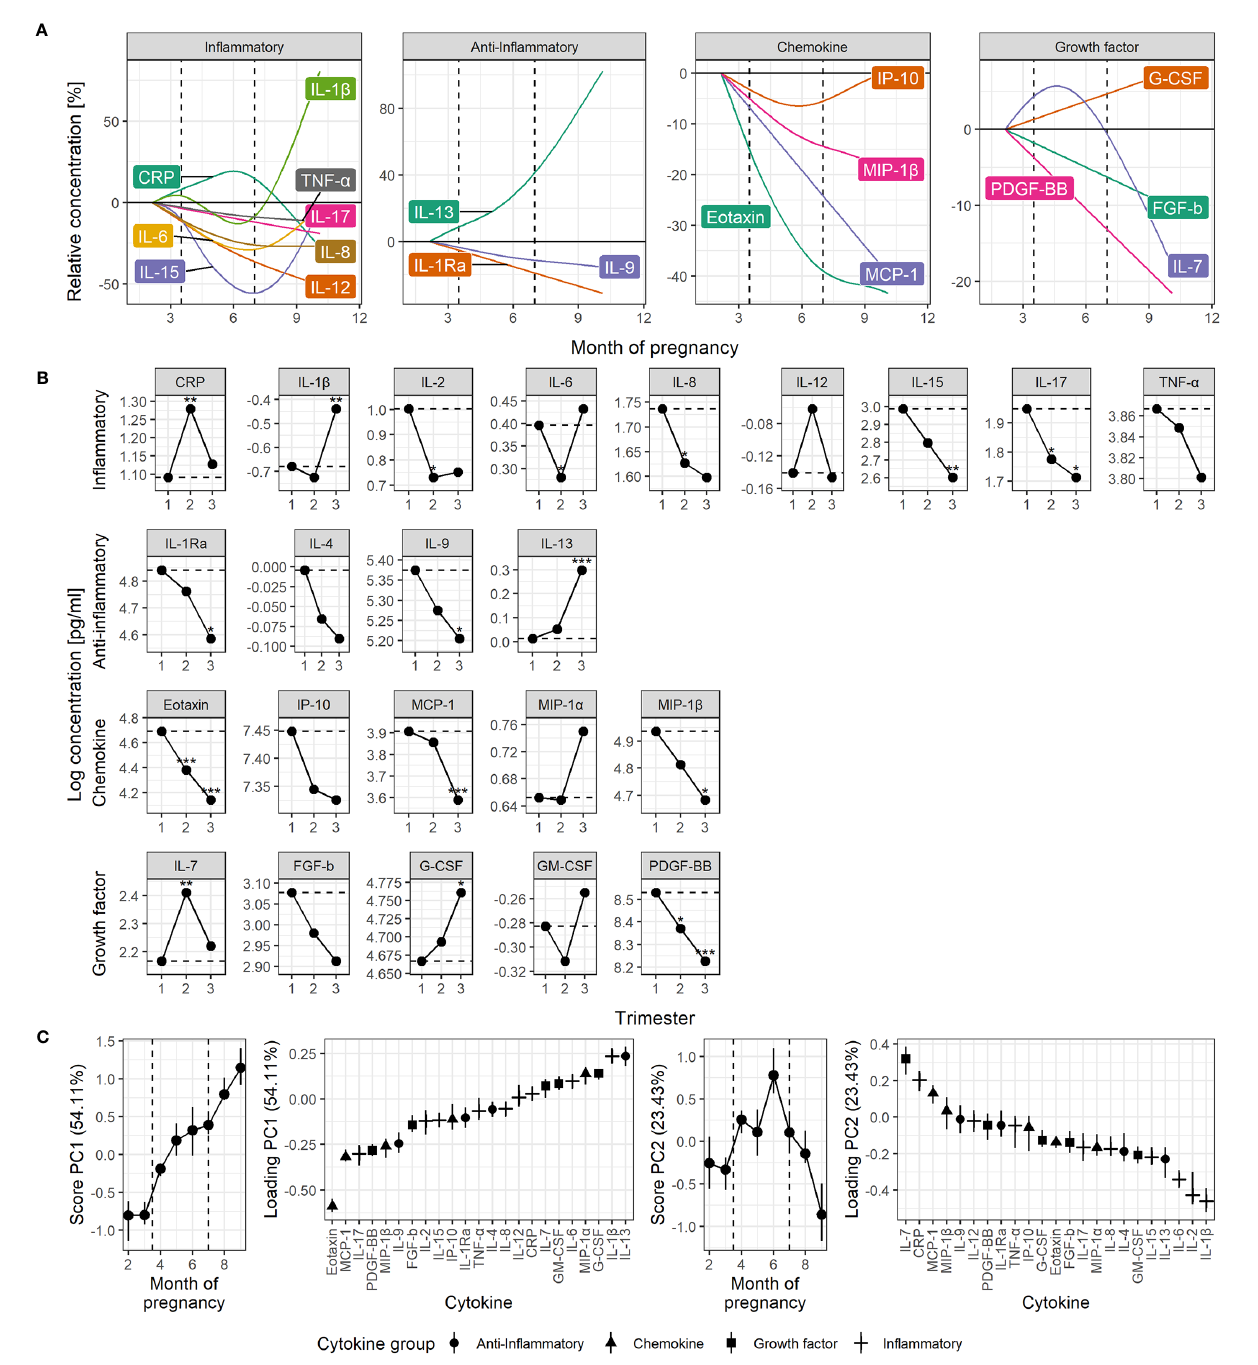
FIGURE 1 | Time course of serum cytokine levels throughout normal pregnancy. (A) Cytokine levels by functional group, shown relative to early pregnancy. Trajectories are estimated by generalized additive linear mixed models. The dashed lines indicate the trimesters. (B) Cytokine levels shown by trimester estimated by univariate linear mixed models. Asterisks indicate signi fi cant change from the fi rst trimester (dashed line). (C) RM-ASCA+ analysis of the longitudinal serum cytokine pro fi le. Loadings (right panels) describe the contribution of each cytokine to the corresponding scores, representing the overall cytokine changes throughout pregnancy (left panels). Higher score translates to higher levels of cytokines with positive loading and lower levels of cytokines with negative loading, and vice versa. Error bars from jackknife validation. The fi rst principal component (PC1) summarizes the most common trends and explains 54% of the cytokine variation over time. Some cytokines have a development not well described by PC1, requiring a separate trajectory (PC2). CRP is measured in µg/mL, cytokines in pg/mL. * P < 0.05, ** P < 0.01, *** P <